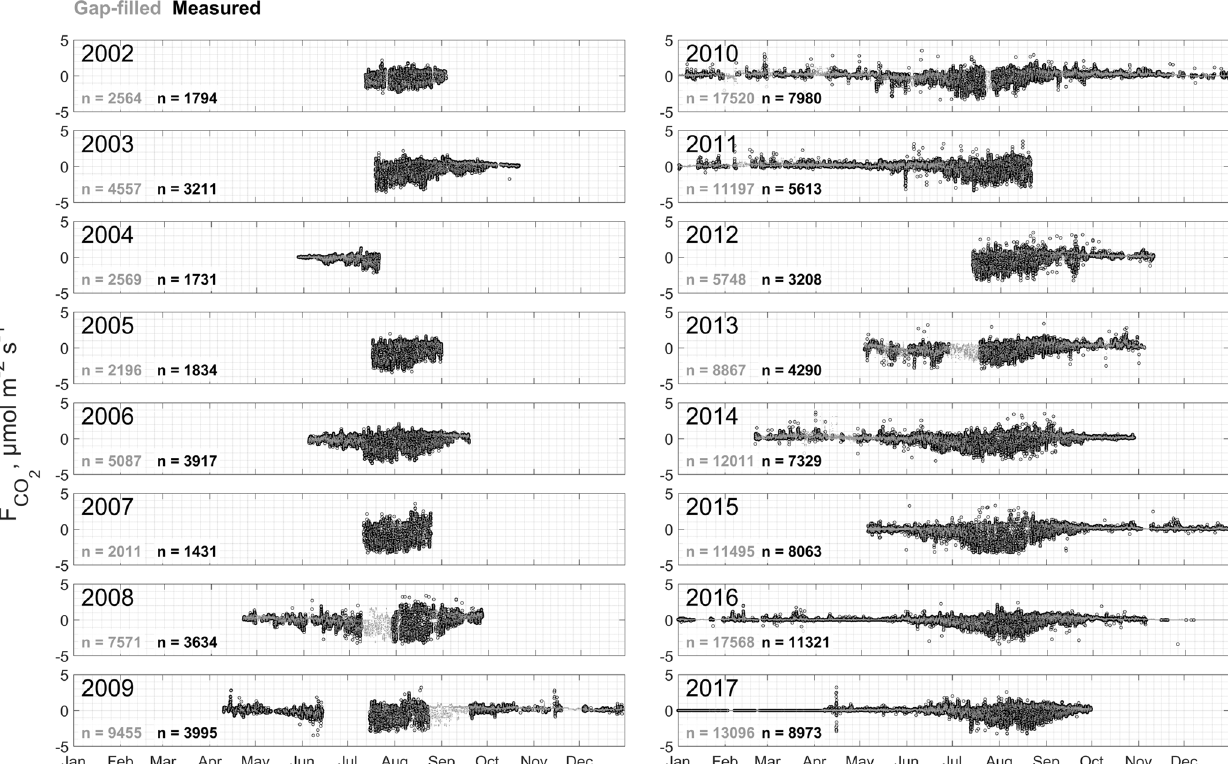
Figure 4. Multi-annual carbon dioxide flux time series compiled from fluxes measured with closed-path and open-path sensors on Samoylov Island’s river terrace. Fluxes of quality class 2 are not shown. Self-heating errors in the OP data set have been corrected for. Additionally, the result from gap filling this time series with the MDS method is shown. The number of values given for the gap-filled time series include measured